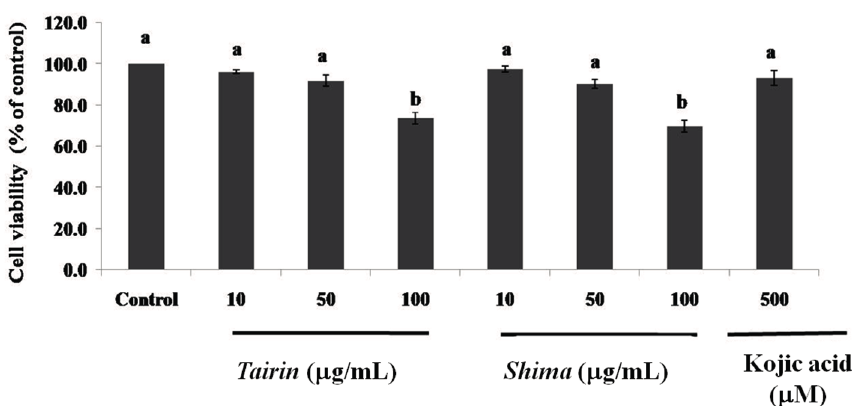
Figure 4. Effect of tairin and shima essenetial oils (EOs) on B16F10 melanoma cell viability. B16F10 cells were treated with various concentrations of EO and incubated for 48 h. Values shown represent the mean ± standard error for three independent experiments. One-way ANOVA was used for the comparison of multiple group means, followed by the Duncan test ( p < 0.05). Letters with different superscripts indicate samples that are significantly different ( p < 0.05) from each